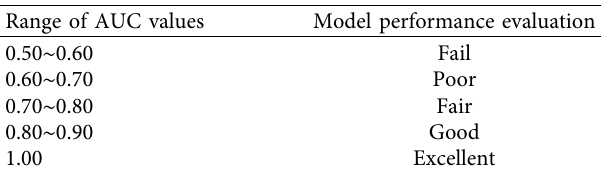
Table 4: AUC value range and its empirical evaluation of the model